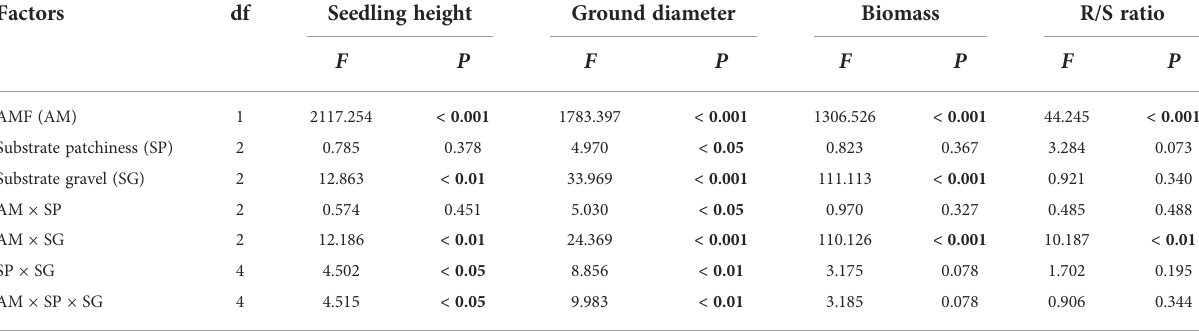
TABLE 2 The three-way ANOVA for the effects of AMF (M + vs. M - ), substrate patchiness (Homo vs. Hetl vs. Hets) and substrate gravel (LG vs. FG vs. HG) treatments on the seedling height, ground diameter, and R/S ratio of B. pilosa . Factors df Seedling